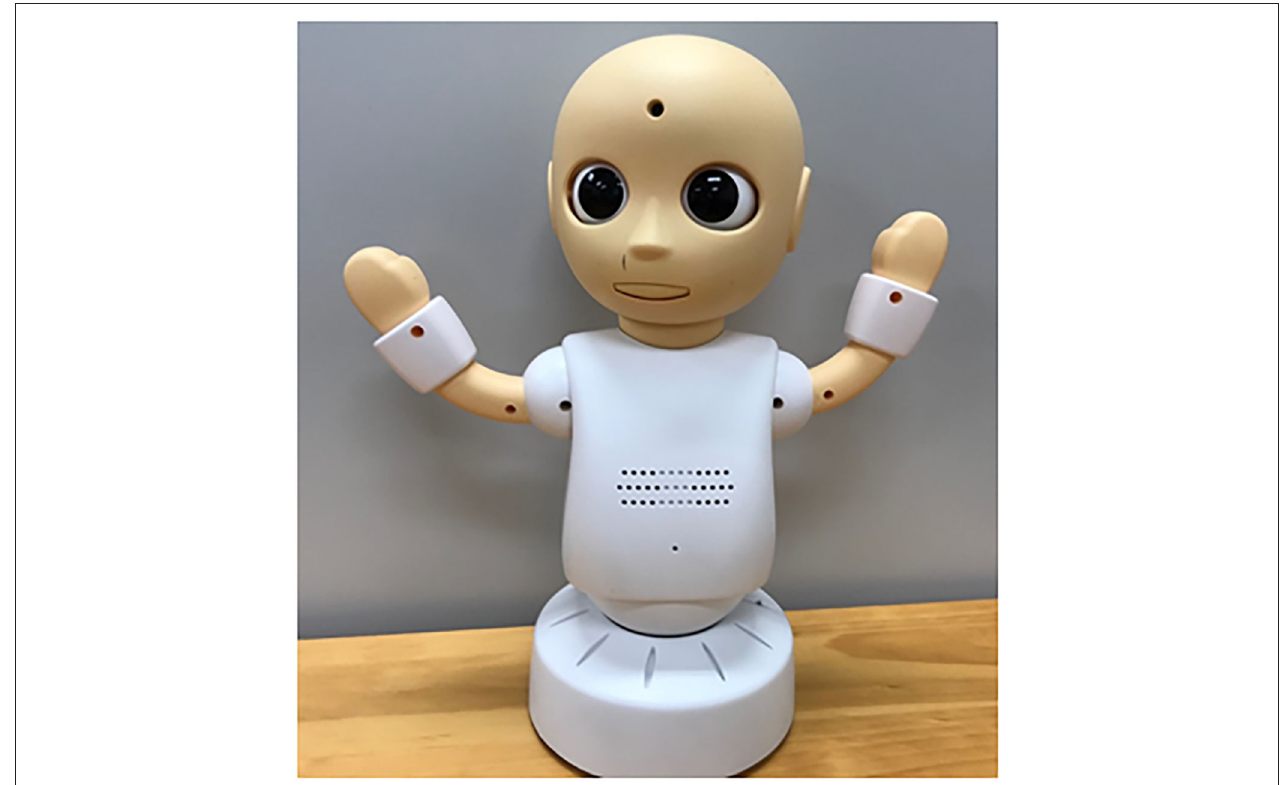
FIGURE 2 | The CommU